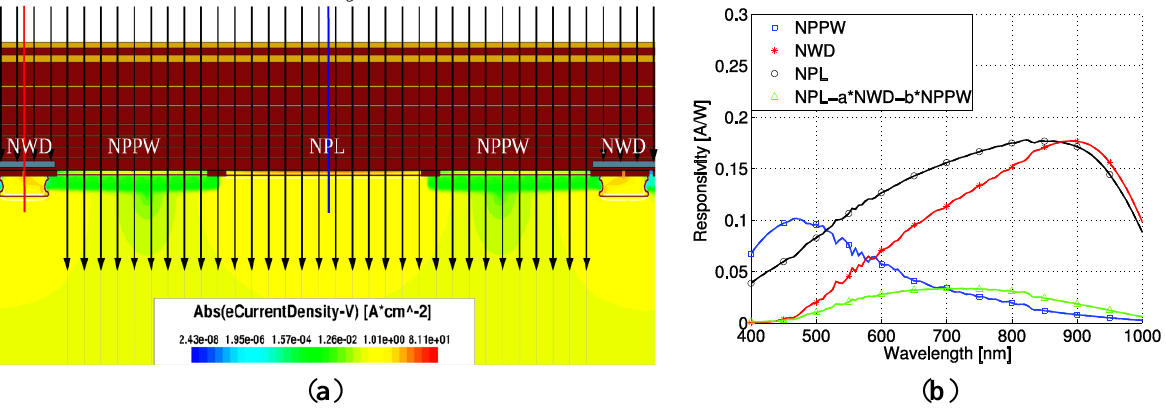
Figure 5. ( a ) Simulated electron current density of the color sensor structure; ( b ) Simulation results of the responsivity of uncovered NPL and NWD photodiodes without the influence of the oxide/dielectric